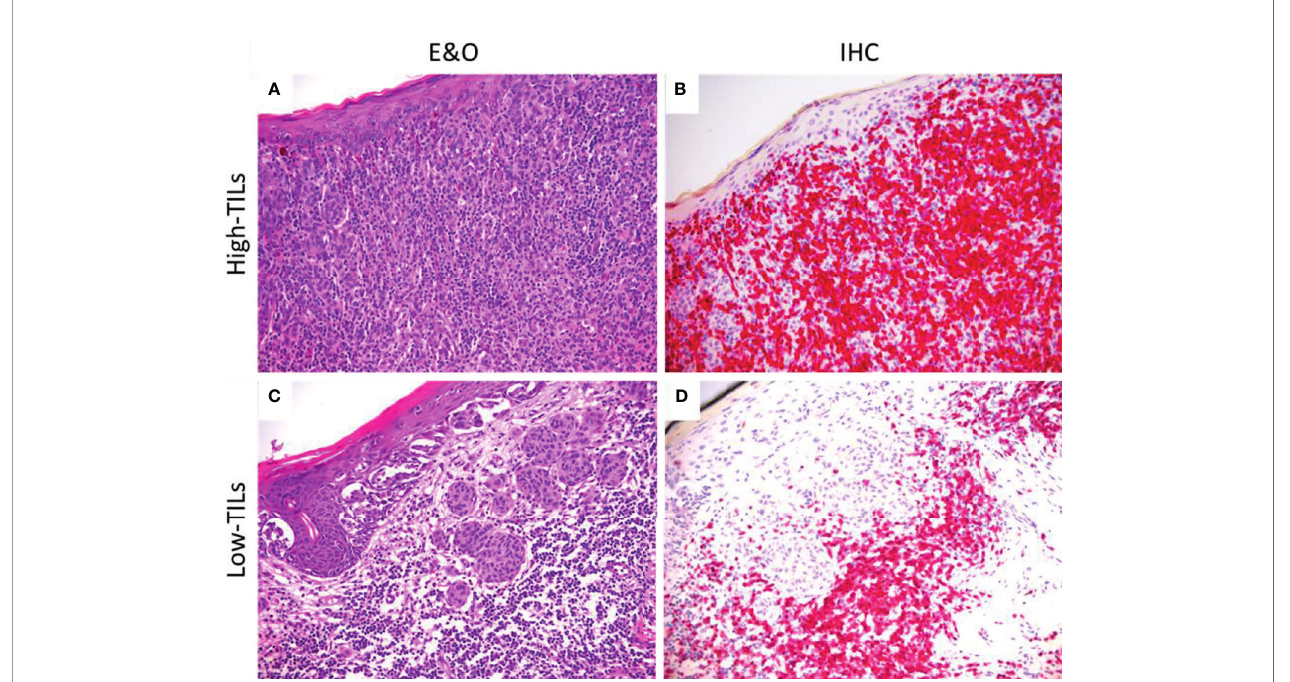
FIGURE 2 | Hematoxylin and eosin staining (left) and CD3 immunohistochemistry (right) demonstrating different degrees of lymphocytic in fi ltration. (A, B) Melanoma with marked lymphocytic in fi ltration, here classi fi ed as “ high TILs ” . (C, D) Melanoma with lymphocytes surrounding but not in fi ltrating tumor cells, here classi fi ed as “ low TILs ” . (A – C) Hematoxylin and eosin staining (E&O); original magni fi cation, 100×. (B – D) Immunostaining (IHC) for CD3; original magni fi cation,